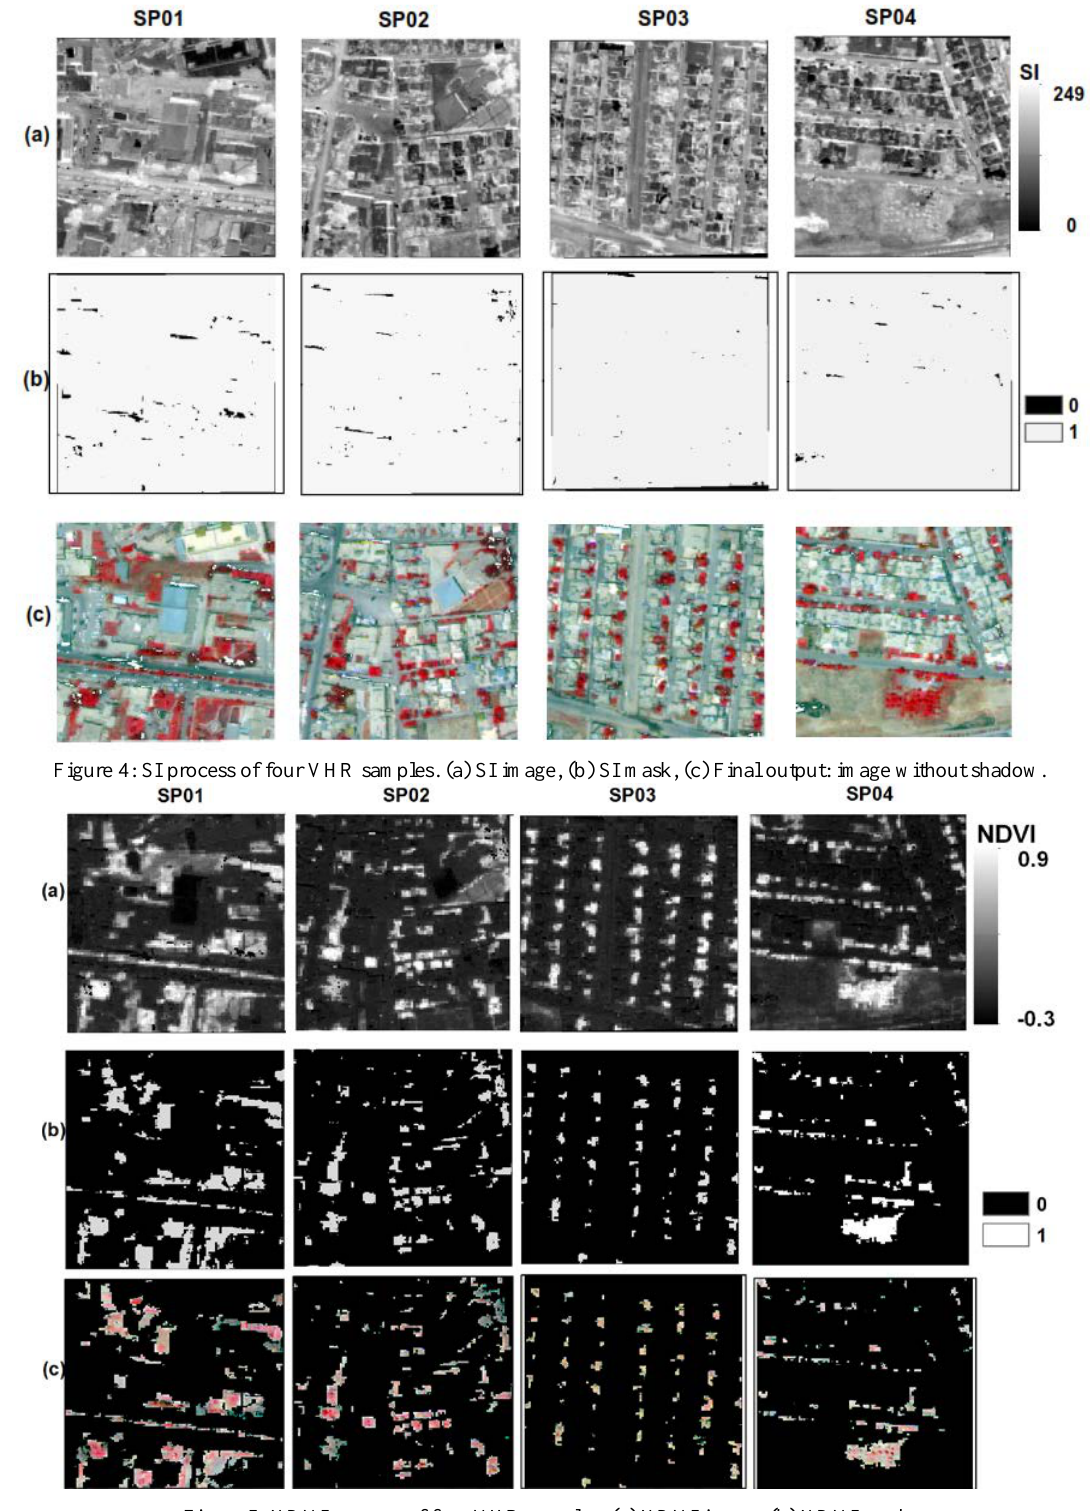
Figure 5: NDVI process of four VHR samples. (a) NDVI image, (b) NDVI mask, (c) Final output: image with vegetation canopy